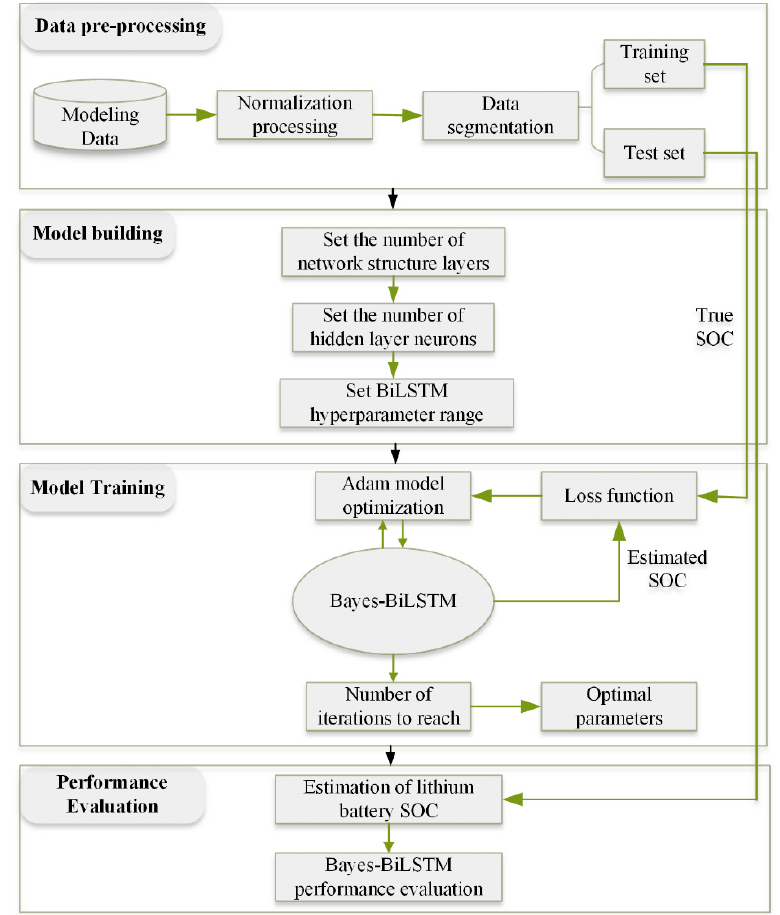
Figure 5. Experimental